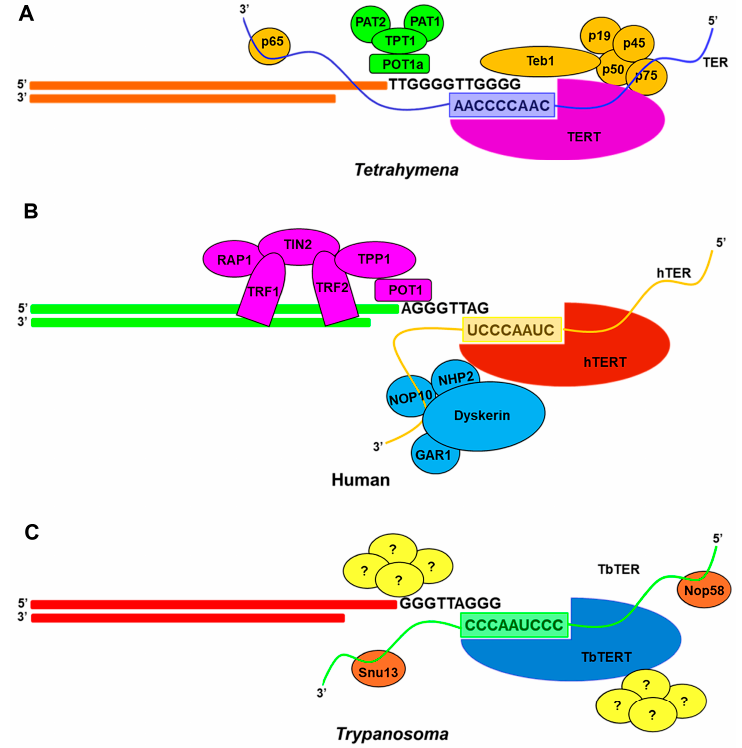
Figure 4. Telomerase and telomere associated protein are illustrated for ( A ) Tetrahymena ( B ) Human and ( C ) Trypanosoma . ‘?’ represents uncharacterized proteins involved in both the formation of active telomerase complex and associated to telomeric end in Trypanosoma .